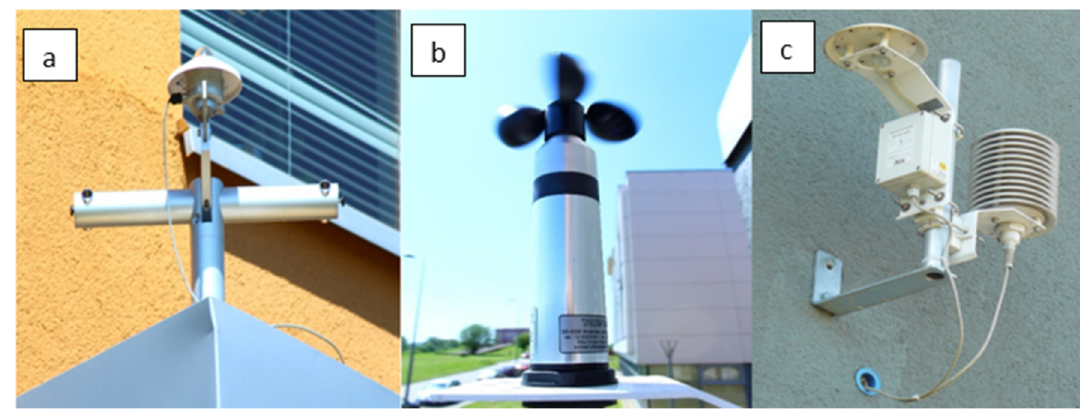
Figure 6. Hydraulic system.